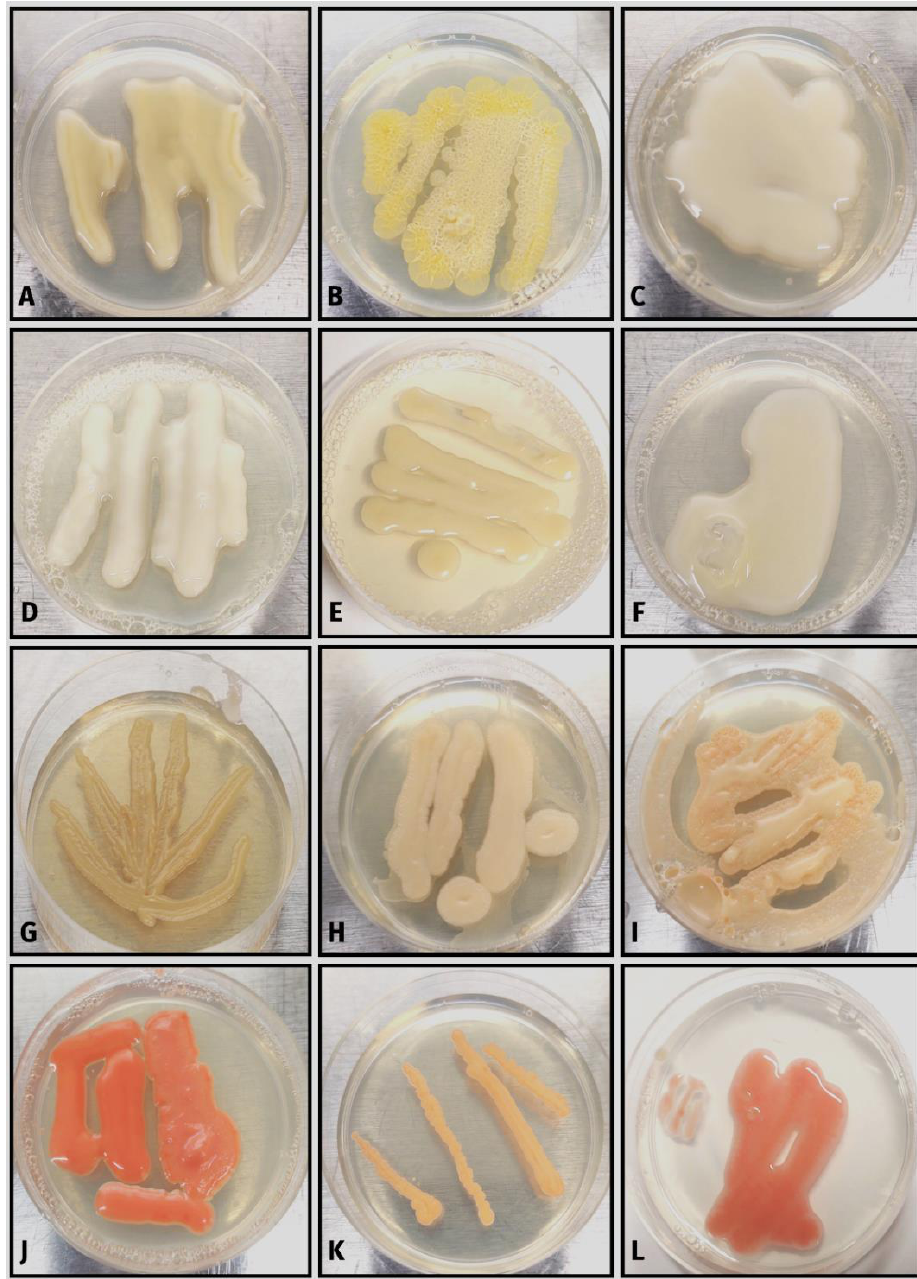
Figure 6. Lichen-associated isolates from the Basidiomycota classes Microbotryomycetes and Tremellomycetes: ( A – C ) Tremella spp.; ( D ) Heterocephalacria sp.; ( E ) Kwoniella sp.; ( F ) Papiliotrema sp.; ( G ) Carcinomyces sp.; ( H , I ) Curvibasidium nothofagi ; ( J , K ) Sporobolomyces spp.; ( L ) Rhodotorula sp.